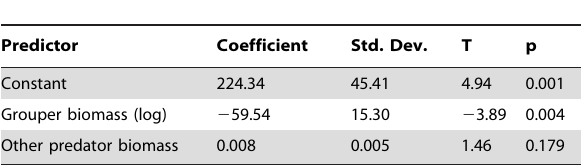
Table 1. Linear regression of lionfish biomass (g 100 m 2 2 ) on the biomass of grouper (g 100 m 2 2 ) and other predator fishes (g 100 m 2 2